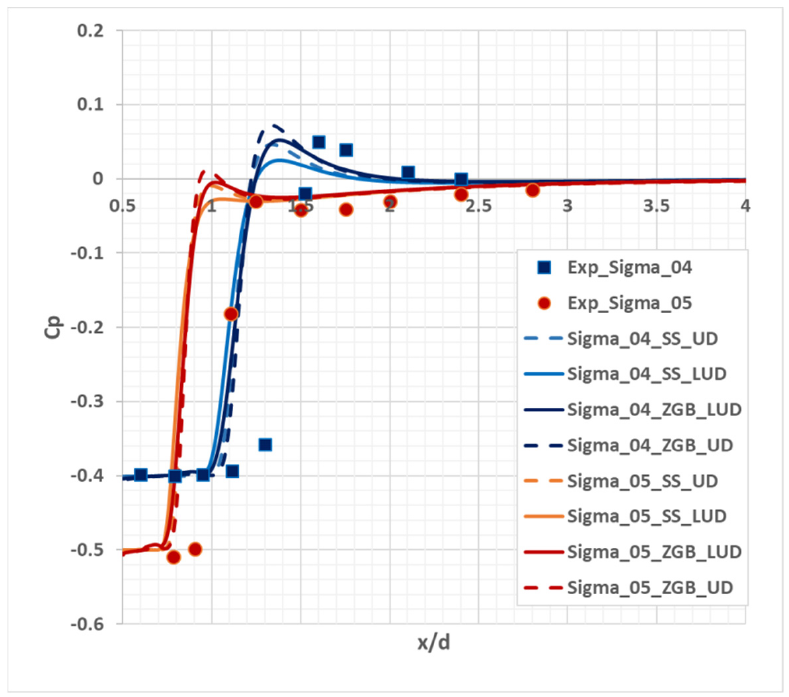
Figure 4. The pressure coefficient distribution over the length of the cylinder with semispherical end.